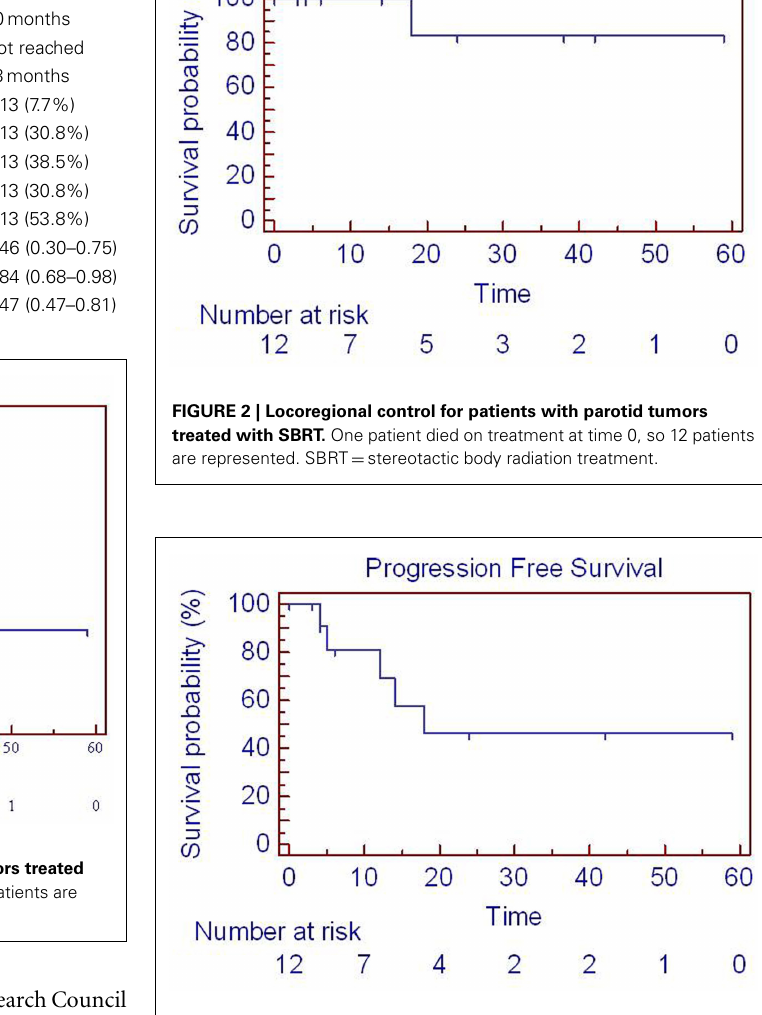
FIGURE 3 | Progression-free survival for patients with parotid tumors with SBRT. One patient died on treatment at time 0, so 12 patients are represented. SBRT = stereotactic body radiation